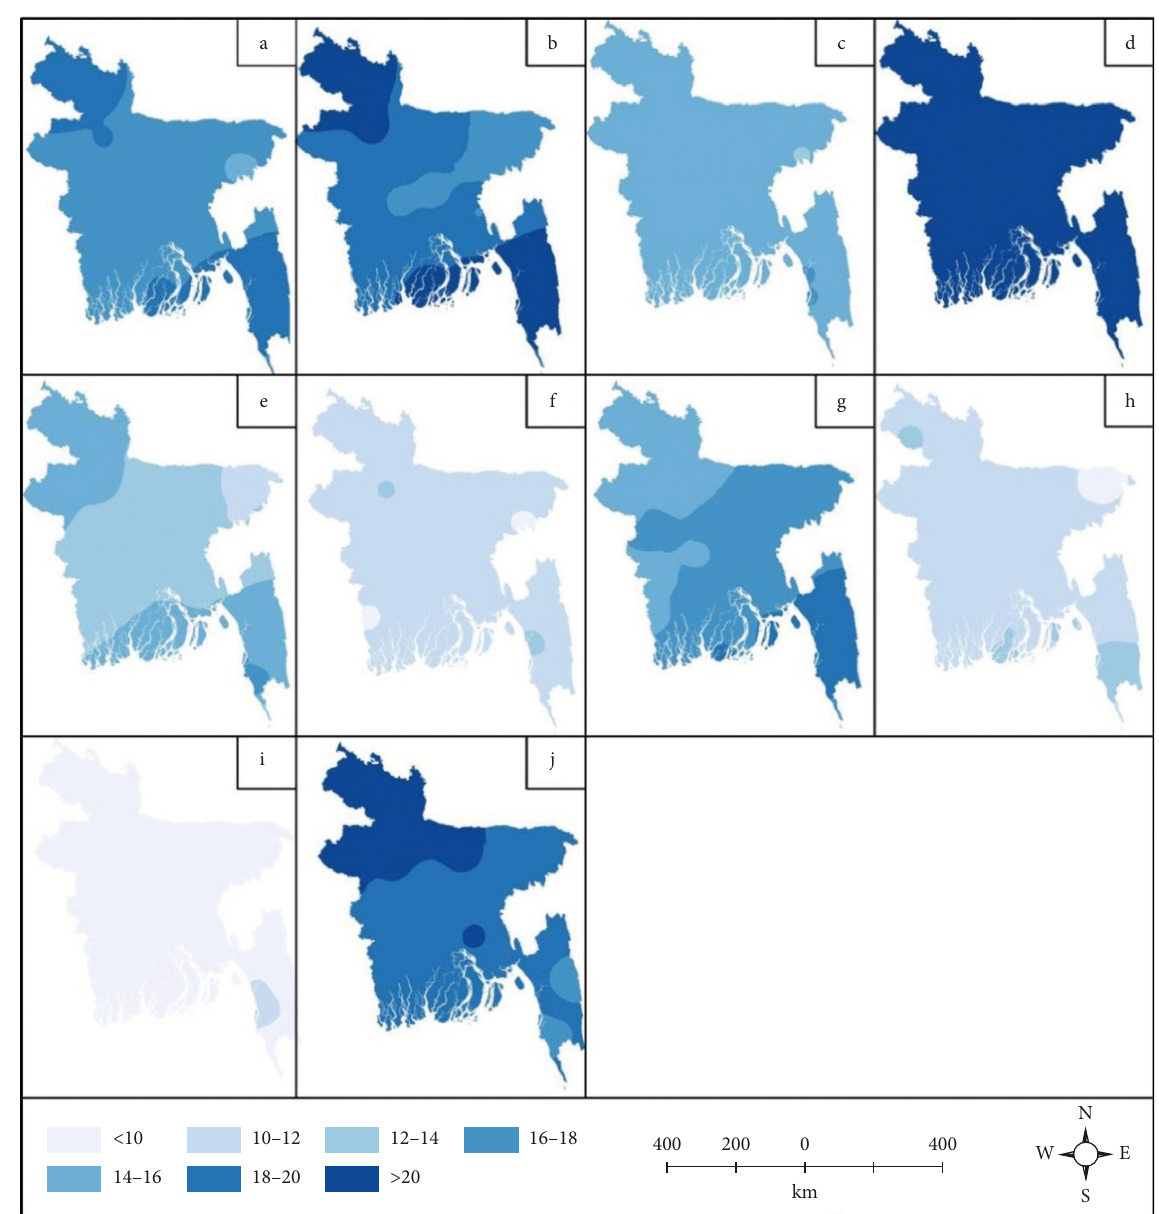
Figure 3: (a) Annual;(b, c)supraseasonal (b � JJ, c � JD); (d–f)seasonal (d � NDJF, e � MAMJ, f � JASO); (g–j) threemonths (g � JFM,h � AMJ, i � JAS, j �